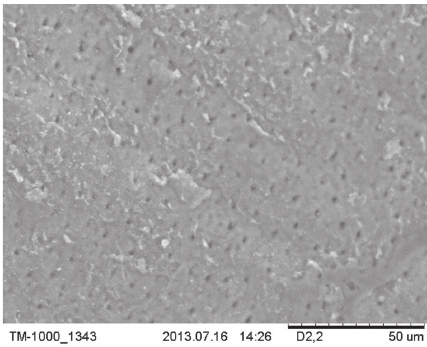
Figure 7: SEM micrograph of a pilot sample in which n-HAp only is applied on DTs. Showing open DTs like the SEM of the control group (C) with some remnant of the n-HAp paste remaining on the dentin surface. The original magnification was ×